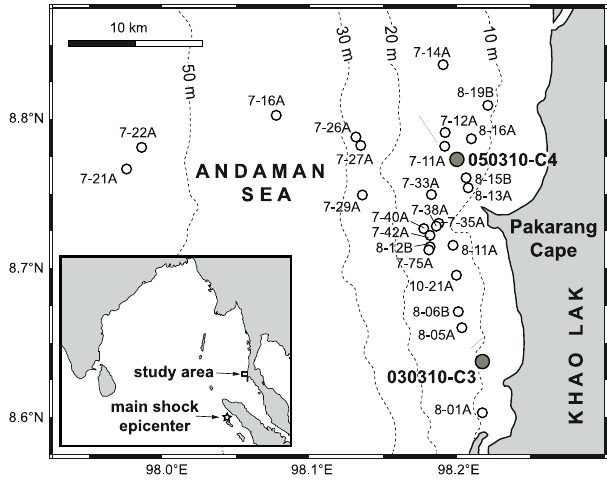
Fig. 1. Bathymetric map of the study area on the inner shelf of the eastern Andaman Sea off Cape Pakarang, Khao Lak, southwestern Thailand. Shown are the locations of the investigated surface sedi- ment sites (small open circles) and the core sites (large grey circles) addressed in this study. See Table 1 for station details. The posi- tions of the study area and the main shock of the 26 December 2004 earthquake are marked in the overview map of the northern Indian